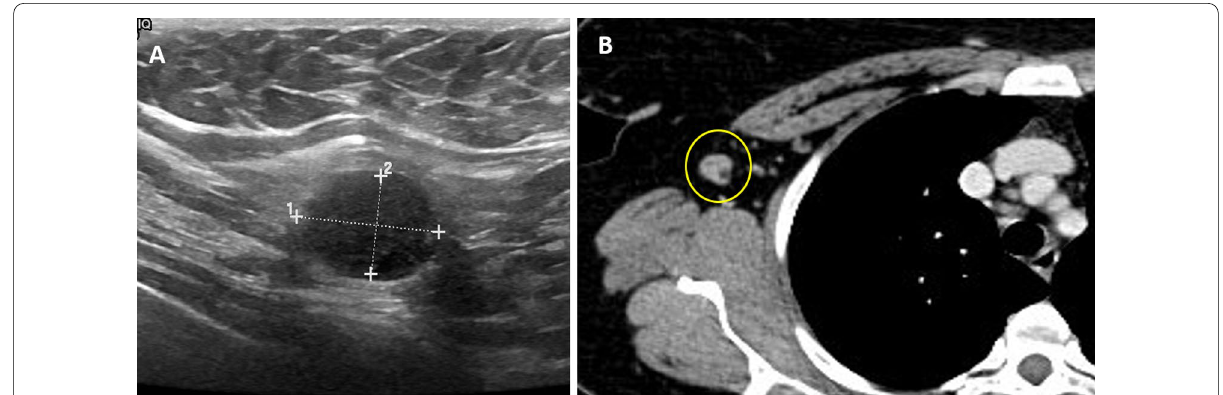
Fig. 4 A 72‑year‑old female with pathologically proven non‑metastatic axillary lymph node. A Axillary ultrasound image shows pathological axillary LN with globular shape and lost fatty hilum (false positive). B CT image shows pathological axillary lymph node with globular shape and eccentric fatty hilum (false positive). LN; Lymph node, CT; computed tomography